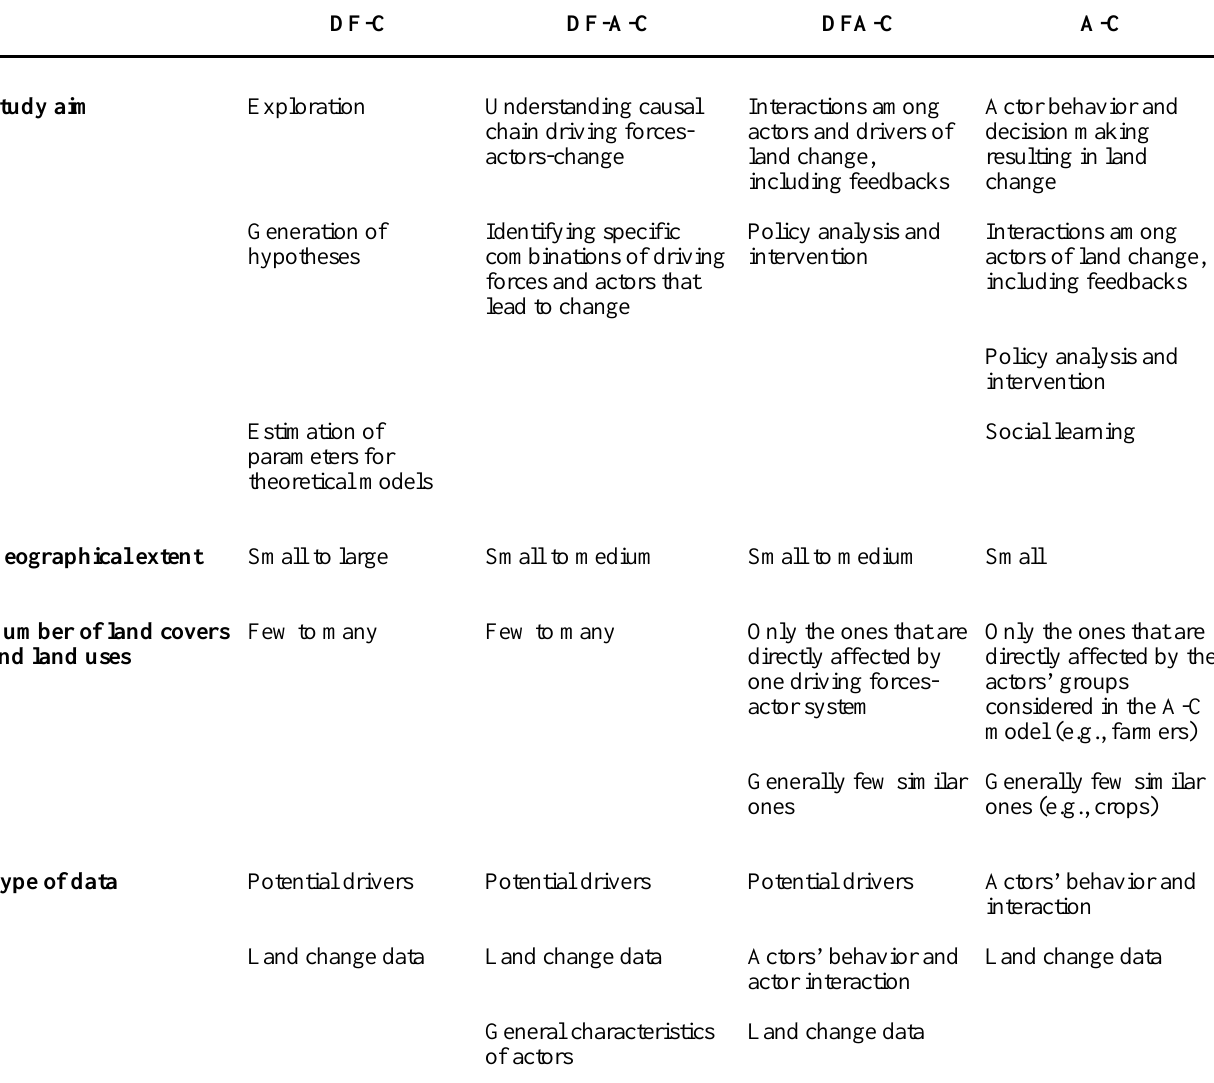
Table 1 . Guidelines for conceptual model selection, based on main model characteristics and practical limitations (DF - driving forces, C - land change, A -